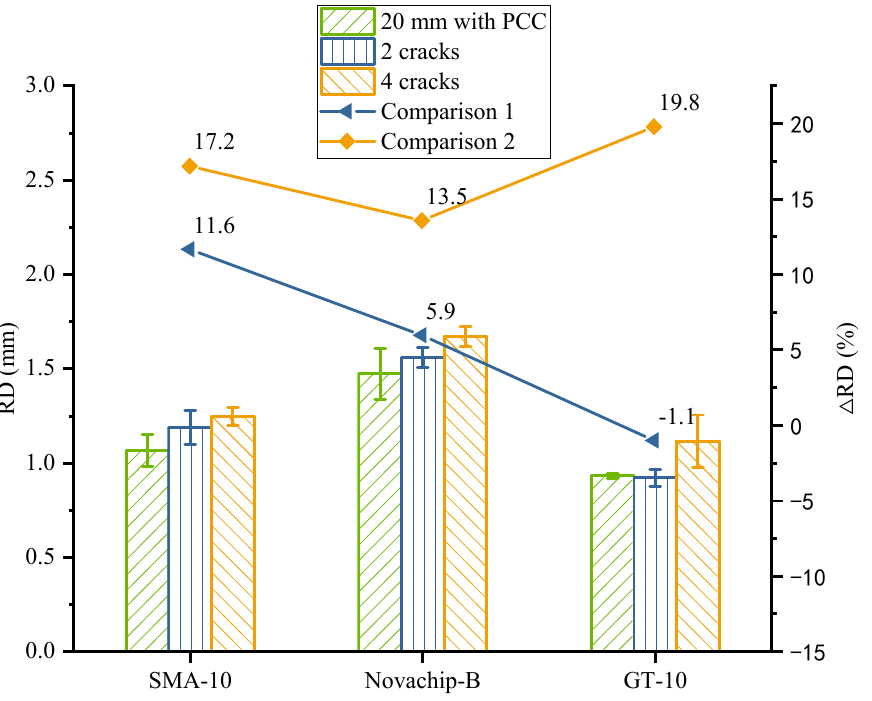
Figure 12. Results of composite specimens with different cracks. Table 8. Results of composite